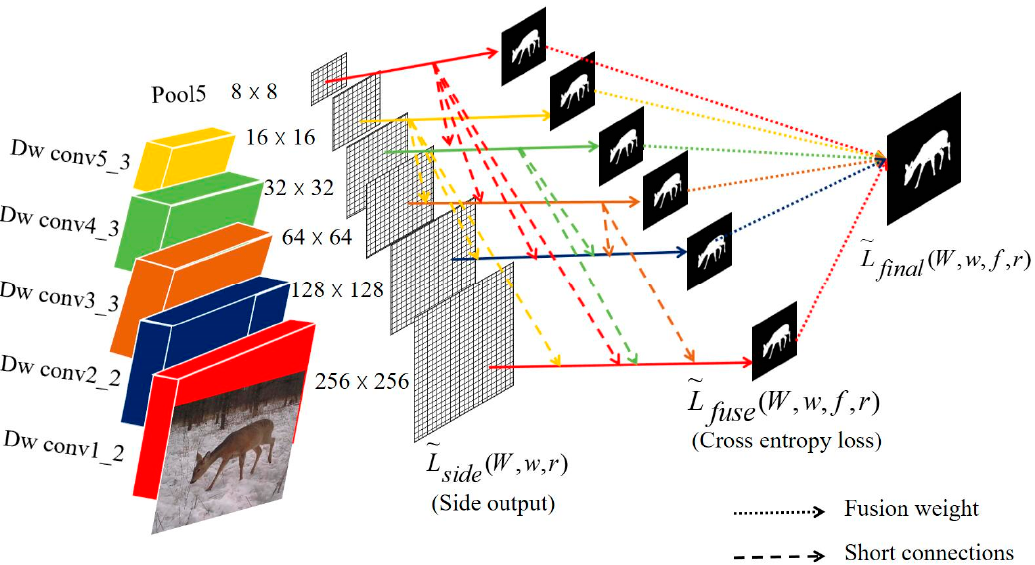
Figure 4. MobileNet Model proposed in our algorithm. Left : Standard convolutional layer with batch normalization and ReLU (Rectified Linear Units). Right : Proposed convolutional layer with group normalization and ReLU.